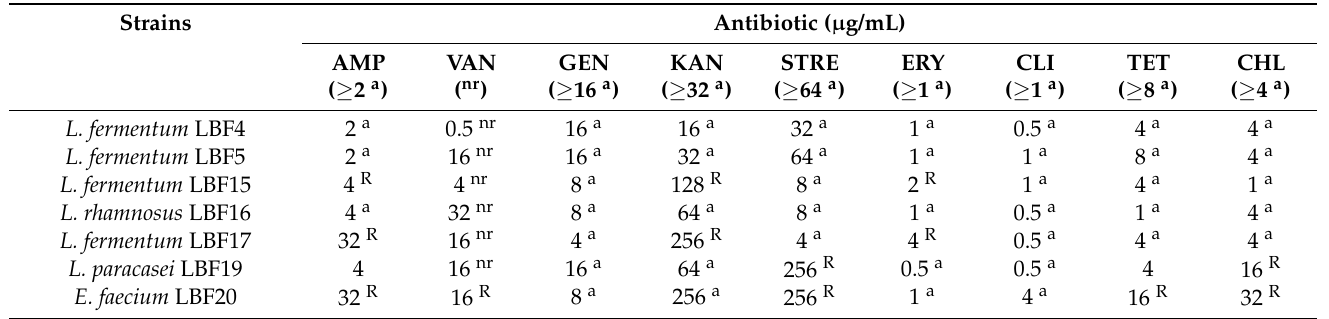
Table 4. Antibiotic susceptibility of LAB